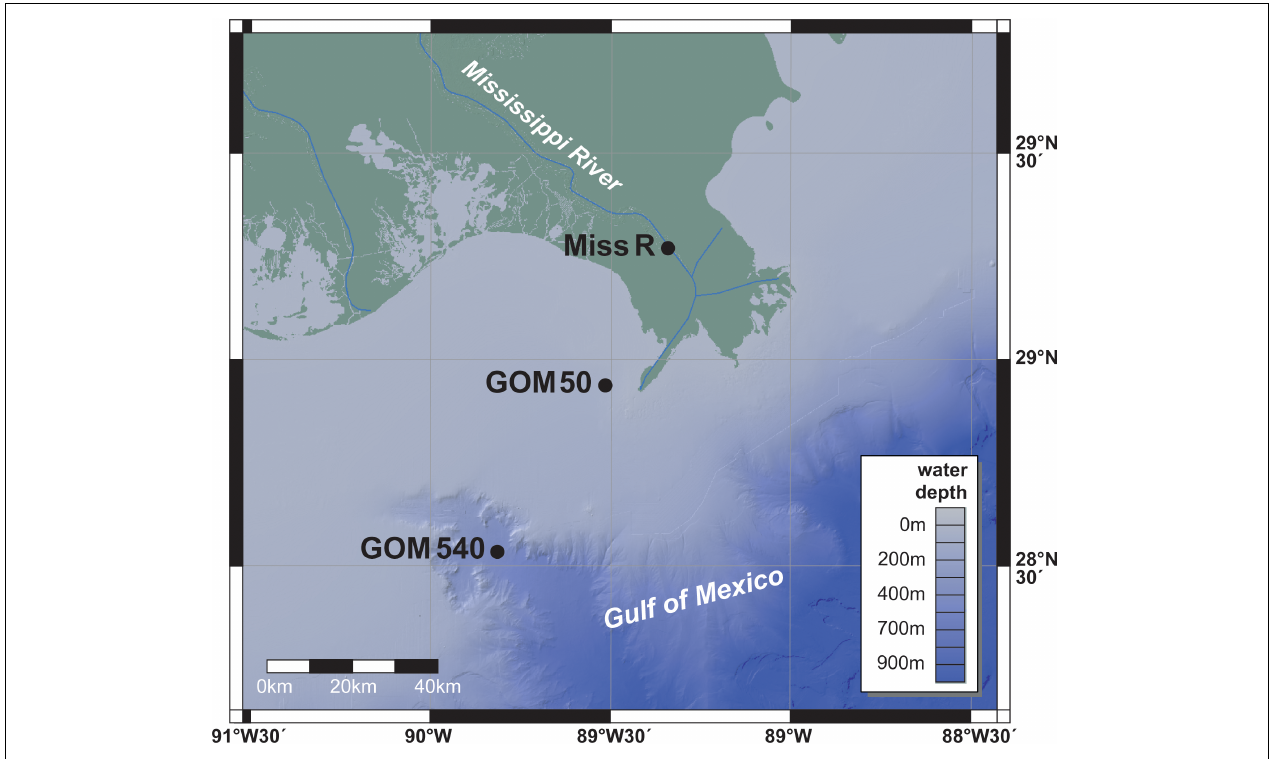
FIGURE 1 | Sampling